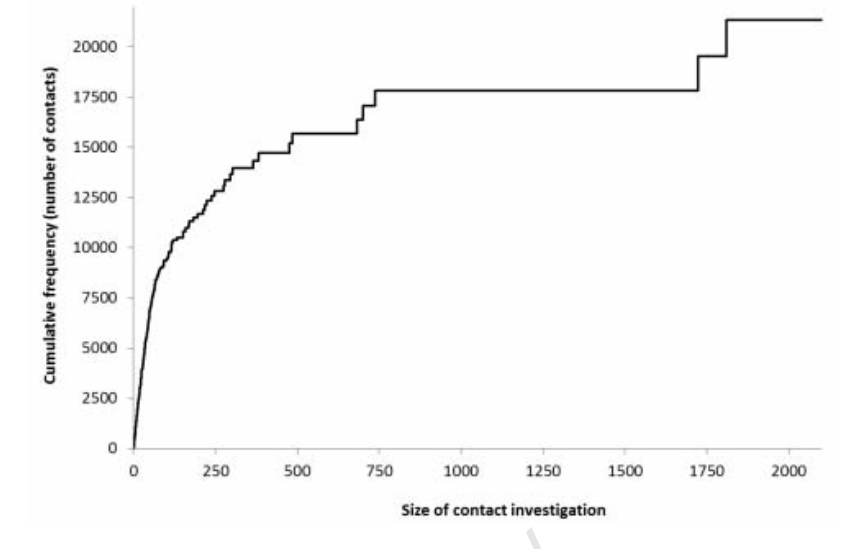
Figure 1. Cumulative number of contacts screened over the period 2001-2006 in source tracing or contact investigations in the Rotterdam-Rijnmond area plotted against the size of the individual contact